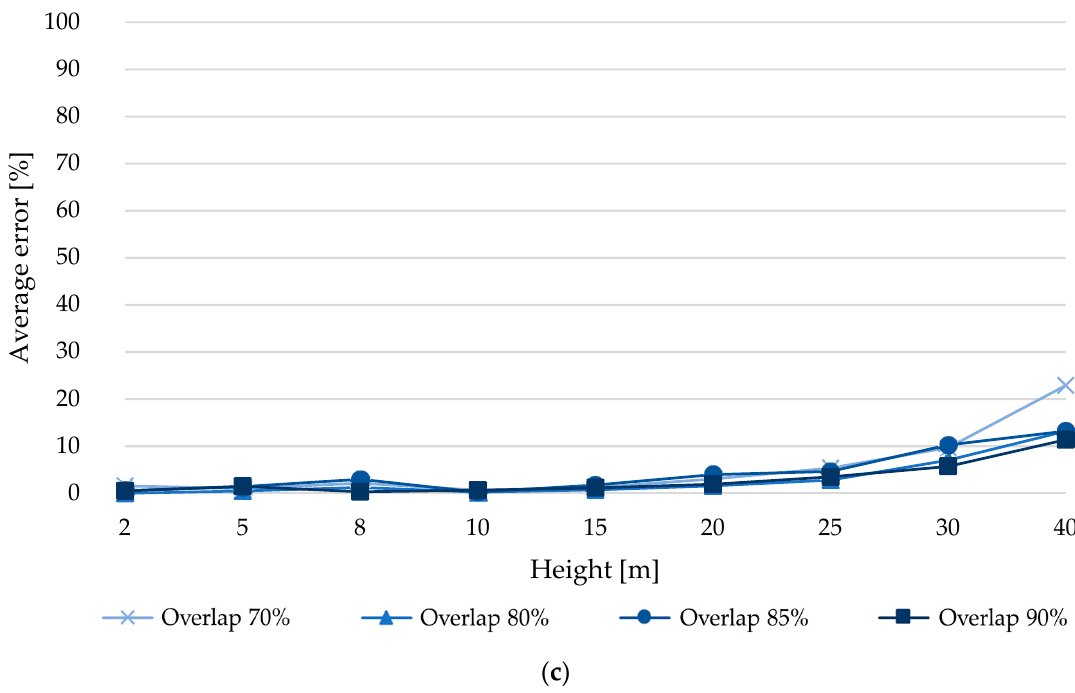
Figure 9. Average relative error severity behavior for different severity levels when varying overlap and height for vertical image acquisition (90°). ( a ) low severity; ( b ) mean severity; ( c ) high severity.